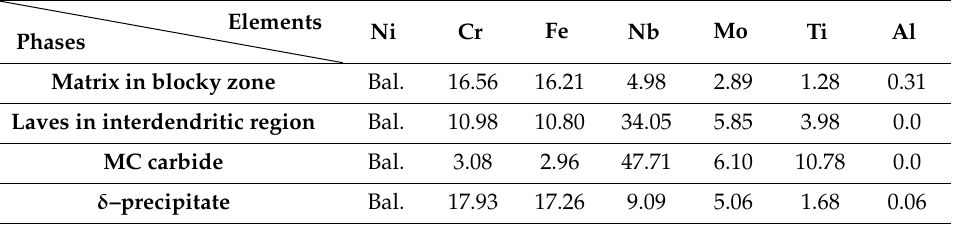
Table 4. Chemical composition (wt.%) in sample heated at 100 ◦ C / s.